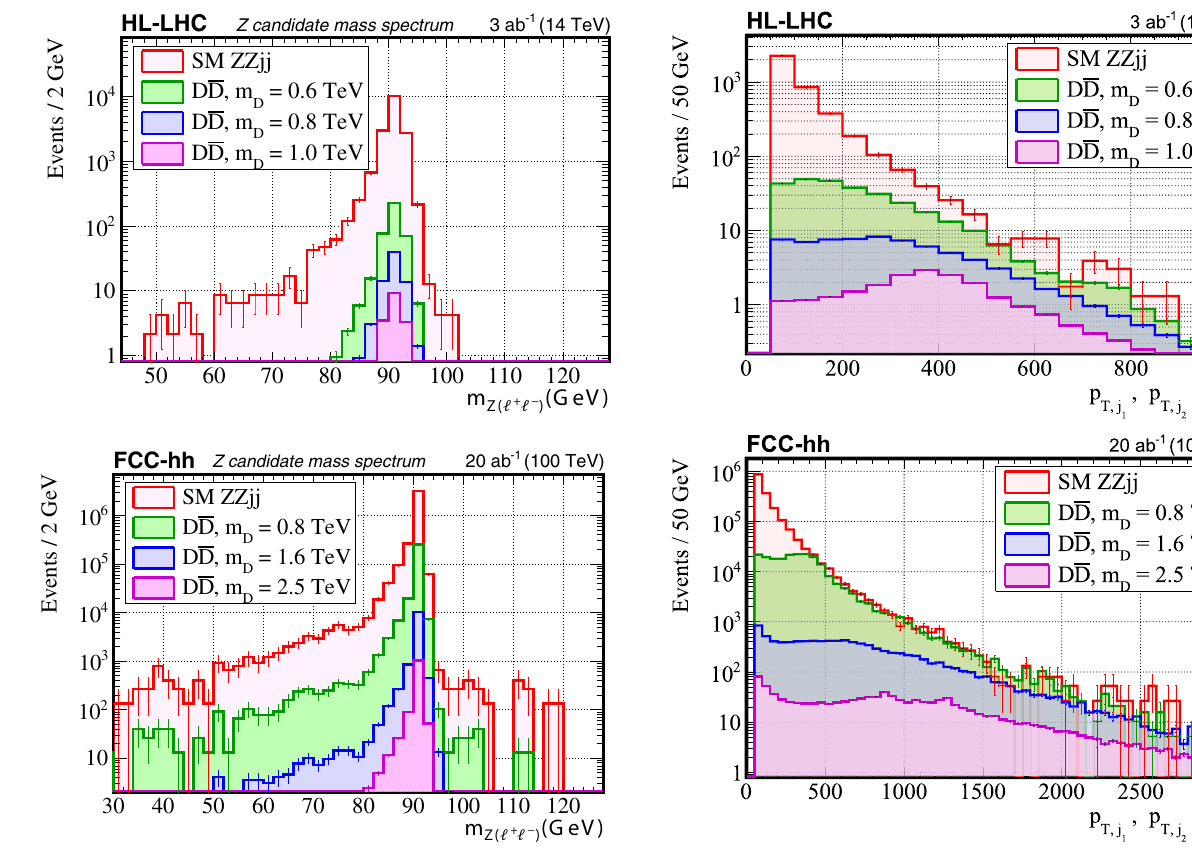
Fig. 3 Invariant mass distribution for both reconstructed Z boson can- didates for HL-LHC (top) and FCC-hh (bottom) conditions. Candidates are reconstructed from both e + e − and μ + μ − pairs selecting jets with high momentum, we use the Heavy- side step function with a weight factor: